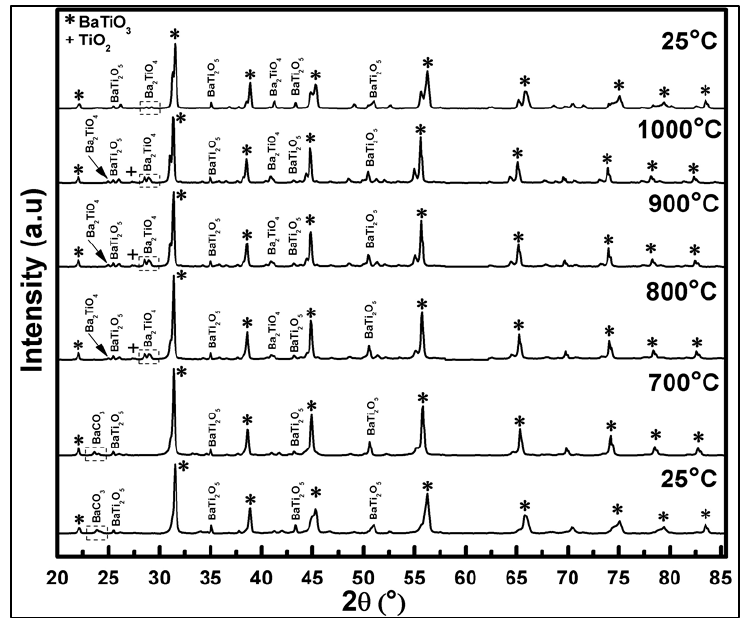
Figure 7. In-situ HT-XRD diffractograms of BaTi 0.95 Rh 0.05 O 3 powder collected over a temperature range varying from 25 °C to 1000 °C and cooling back to 25 °C.